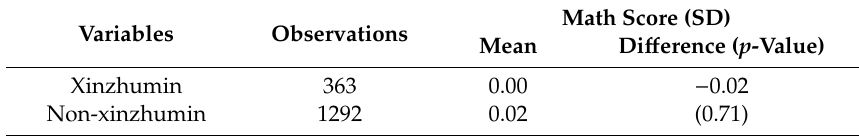
Table A1. Di ff erence of academic performance between Xinzhumin and Non-xinzhumin